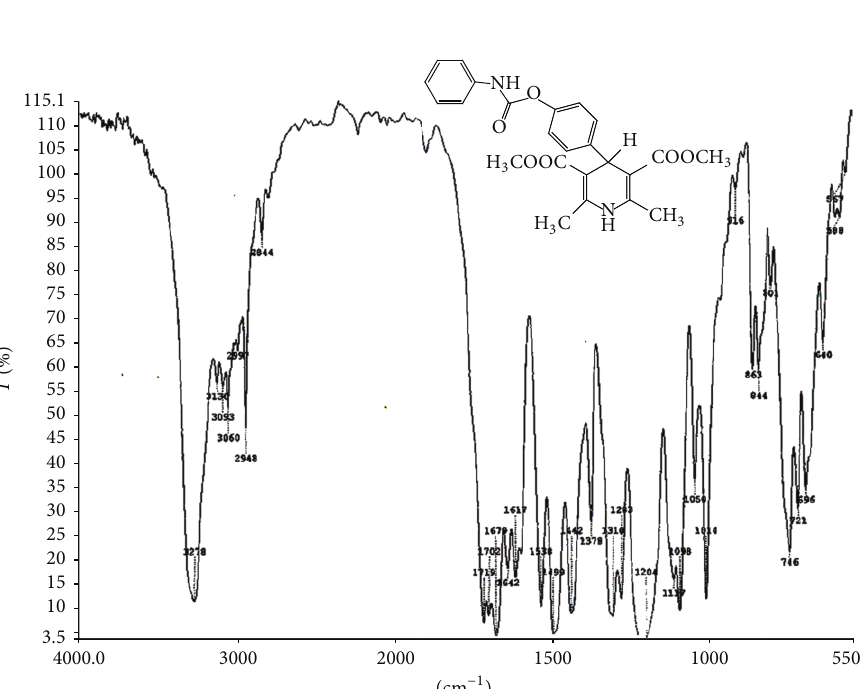
Figure 1: IR spectrum of dimethyl 2,6-dimethyl-4-(4-(phenylcarbamoyloxy)phenyl)-1,4-dihydropyridine-3,5-dicarboxylate ( 2 a